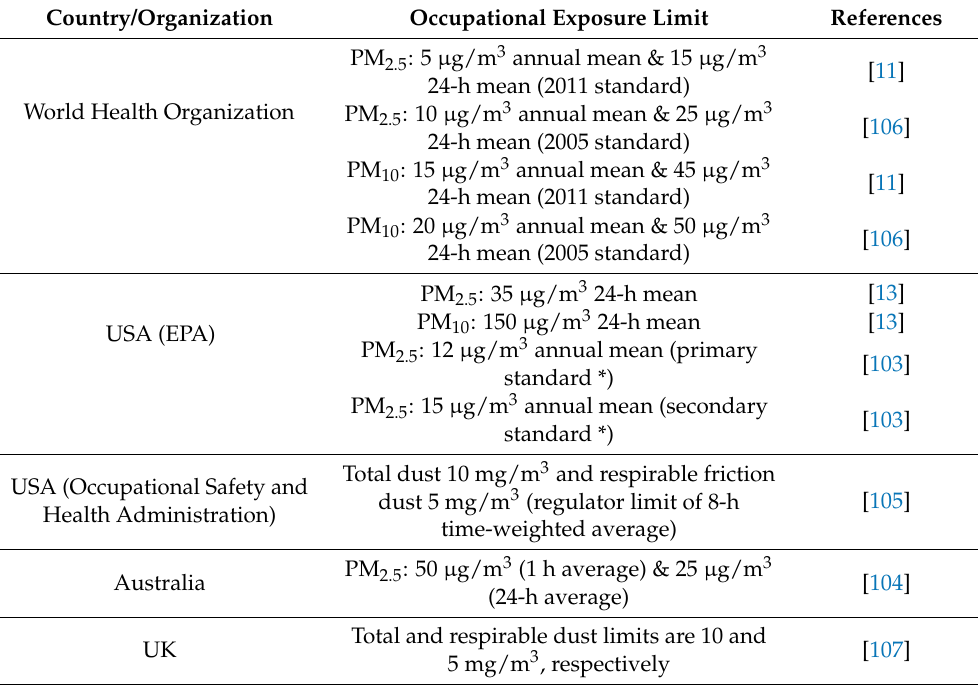
Table 8. Recommended guidelines for PM on occupational exposure limit of various countries or